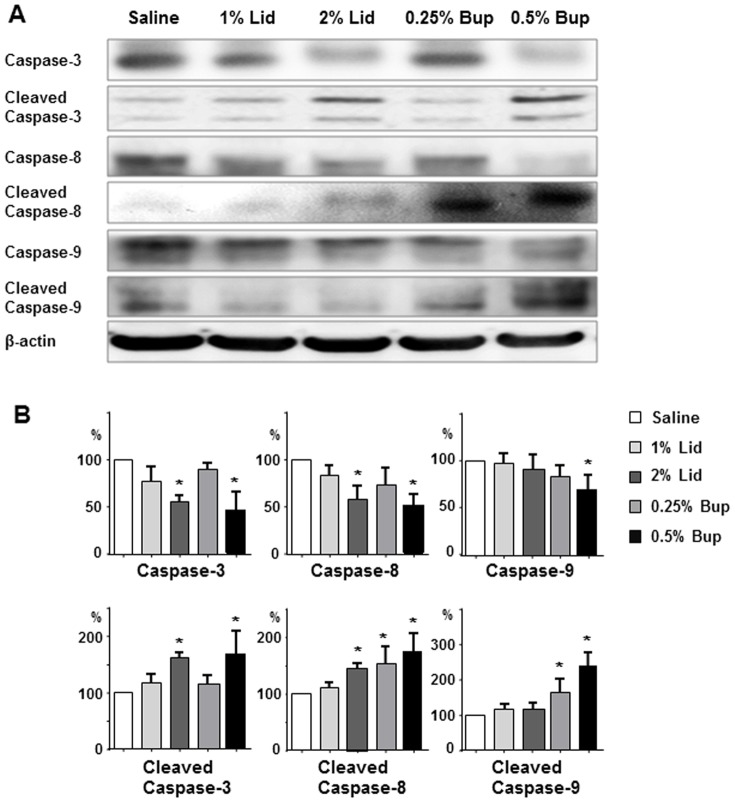
Western blot analysis of the apoptosis signaling pathways stimulated by lidocaine and bupivacaine.NP cell–alginate 3D composites were exposed 60 min to saline or a local anesthetic agent (lidocaine or bupivacaine), cultured 24 h, then the NP cell protein lysates were processed by sodium dodecyl sulfate polyacrylamide gel electrophoresis and immunoblotting with primary antibodies against caspase-3, caspase-8, caspase-9, cleaved caspase-3, cleaved caspase-8, and cleaved caspase-9. β-actin was used as an internal control. (A) Representative Western blot. (B) Densitometry analysis performed via normalization to β-actin. Data are from five independent experiments (mean ± SE; *, p<0.05 vs. saline).